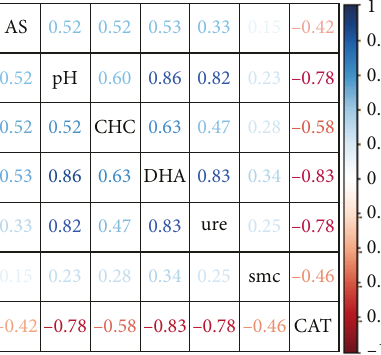
Figure 8: Pearson’s correlation for aggregate stability (AS), pH, CEC, dehydrogenase activity (DHA), urease activity (ure), soil moisture content (smc), and catalase activity (CAT) from Bok Choy amended Sandwich compost, with 4 growth cycles. The “ ∗ ” was indicated as the significant